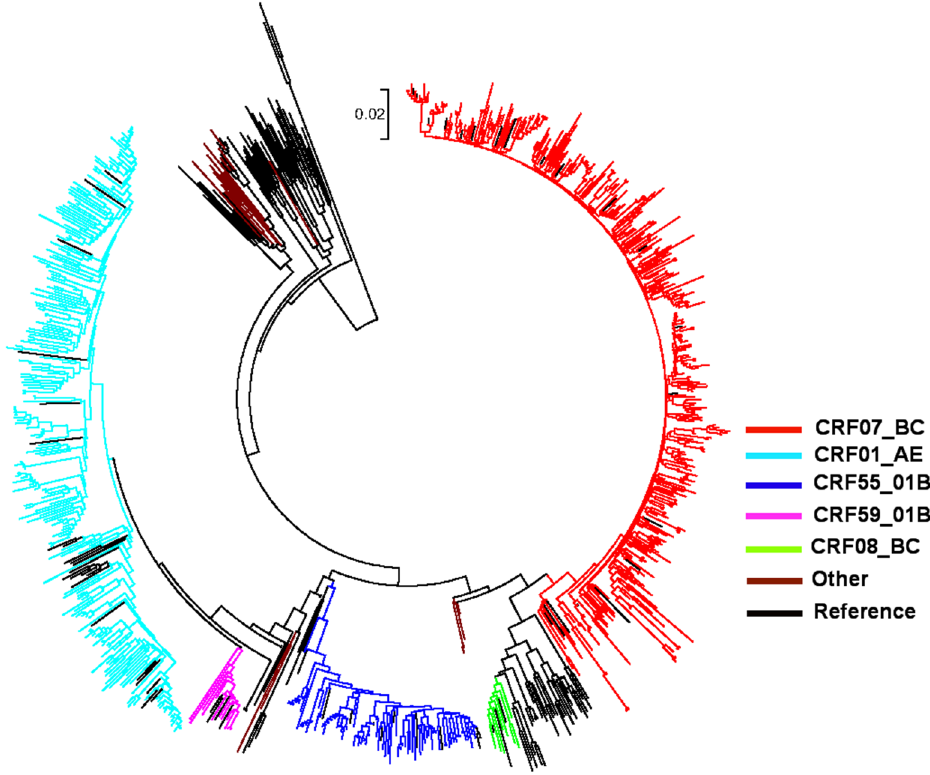
Figure 1. Phylogenetic analysis of the lineages. Phylogenetic tree based on the pol region was constructed using the Neighbour-Joining method and the MEGA7.0 software. The various subtypes are colour-coded.